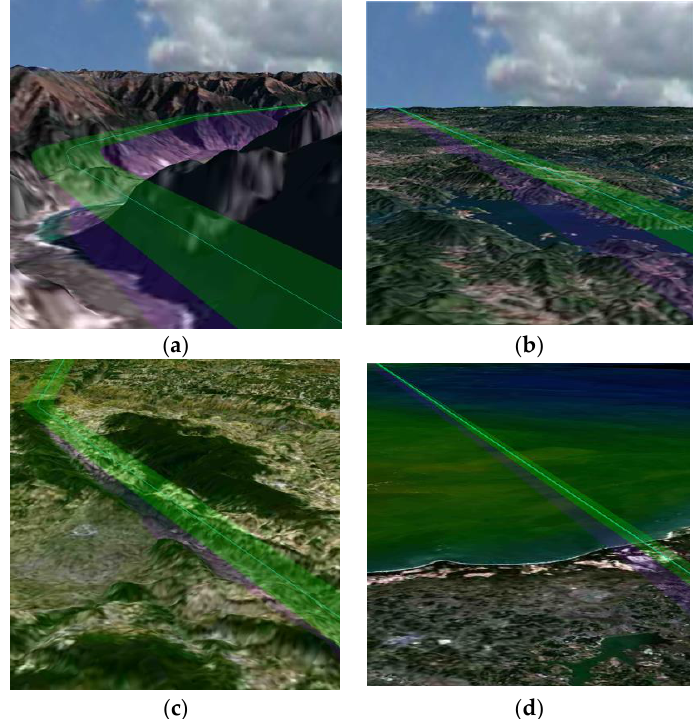
Figure 23. Local details of the routes of 2–5 coordinate groups. ( a ) Coordinate group 2 ; ( b ) Coordinate group 3 ; ( c ) Coordinate group 4 ; ( d ) Coordinate group 5 .